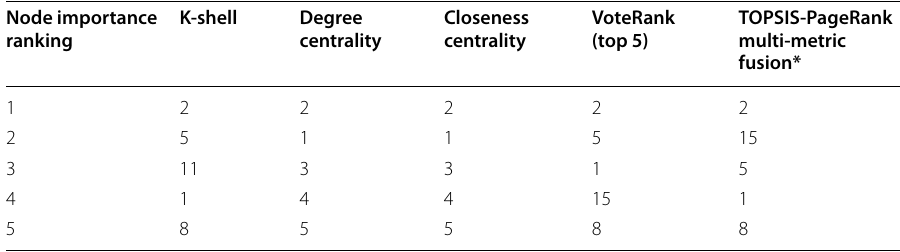
Table 4 Top 5 nodes of importance Node importance ranking